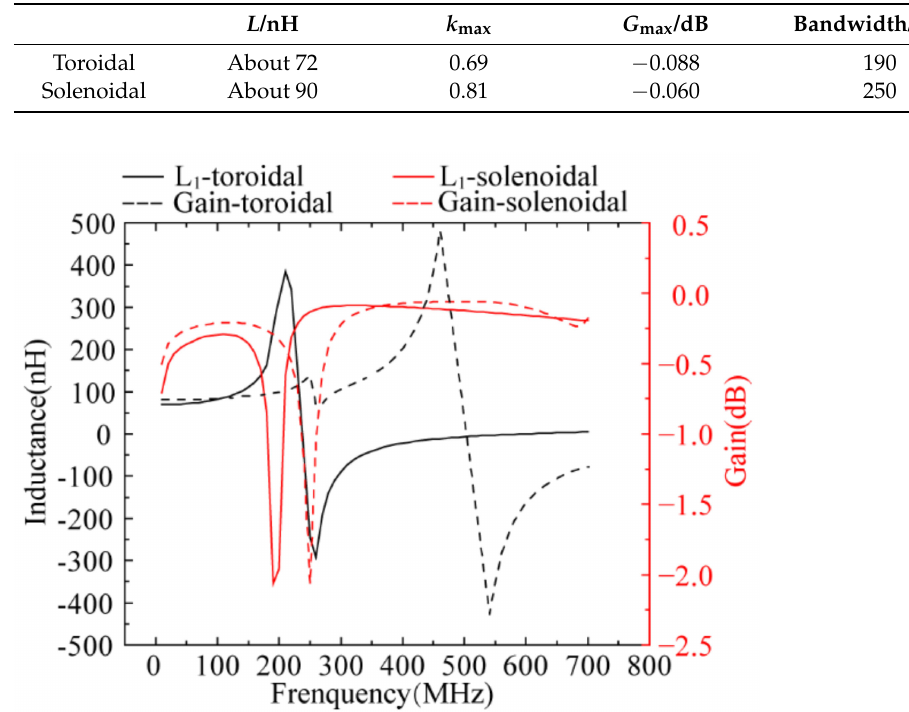
Figure 10. Exposed coils after removal of silicon substrate. Table 7. Simulation results of the two transformers.